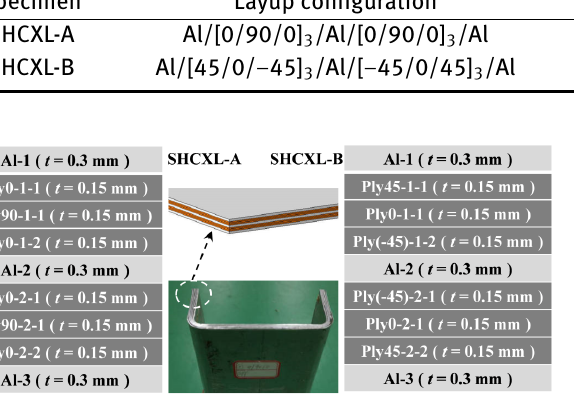
Figure 3: Stack and fiber ply configurations of CARALL specimens.